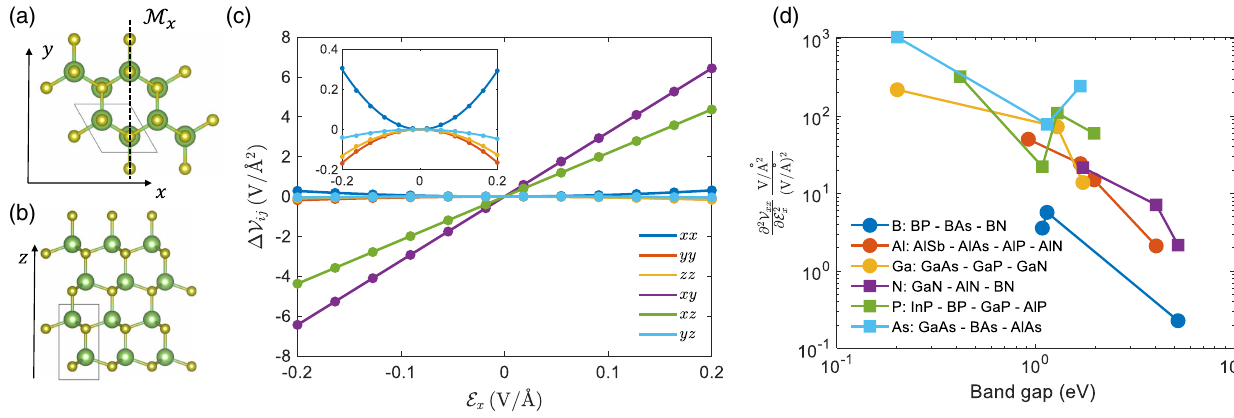
FIG. 2. (a),(b) Atomic structure of wurtzite GaN. The dashed line in (a) labels the mirror symmetry M of wGaN. Green, Ga; yellow, x N. (c) Change in EFG tensor Δ V of Ga nuclei as a function of E . Because of the M symmetry, four of six components of the V ij x x Þj ¼ 0 (inset). (d) ð ∂ 2 V Þj = ∂ E = ∂ E 2 tensor have first-order response ð ∂ V E x ¼ 0 E x ¼ 0 against the band gap E g for all wurtzite III-V x ij x xx > 0 in DFT materials with E g